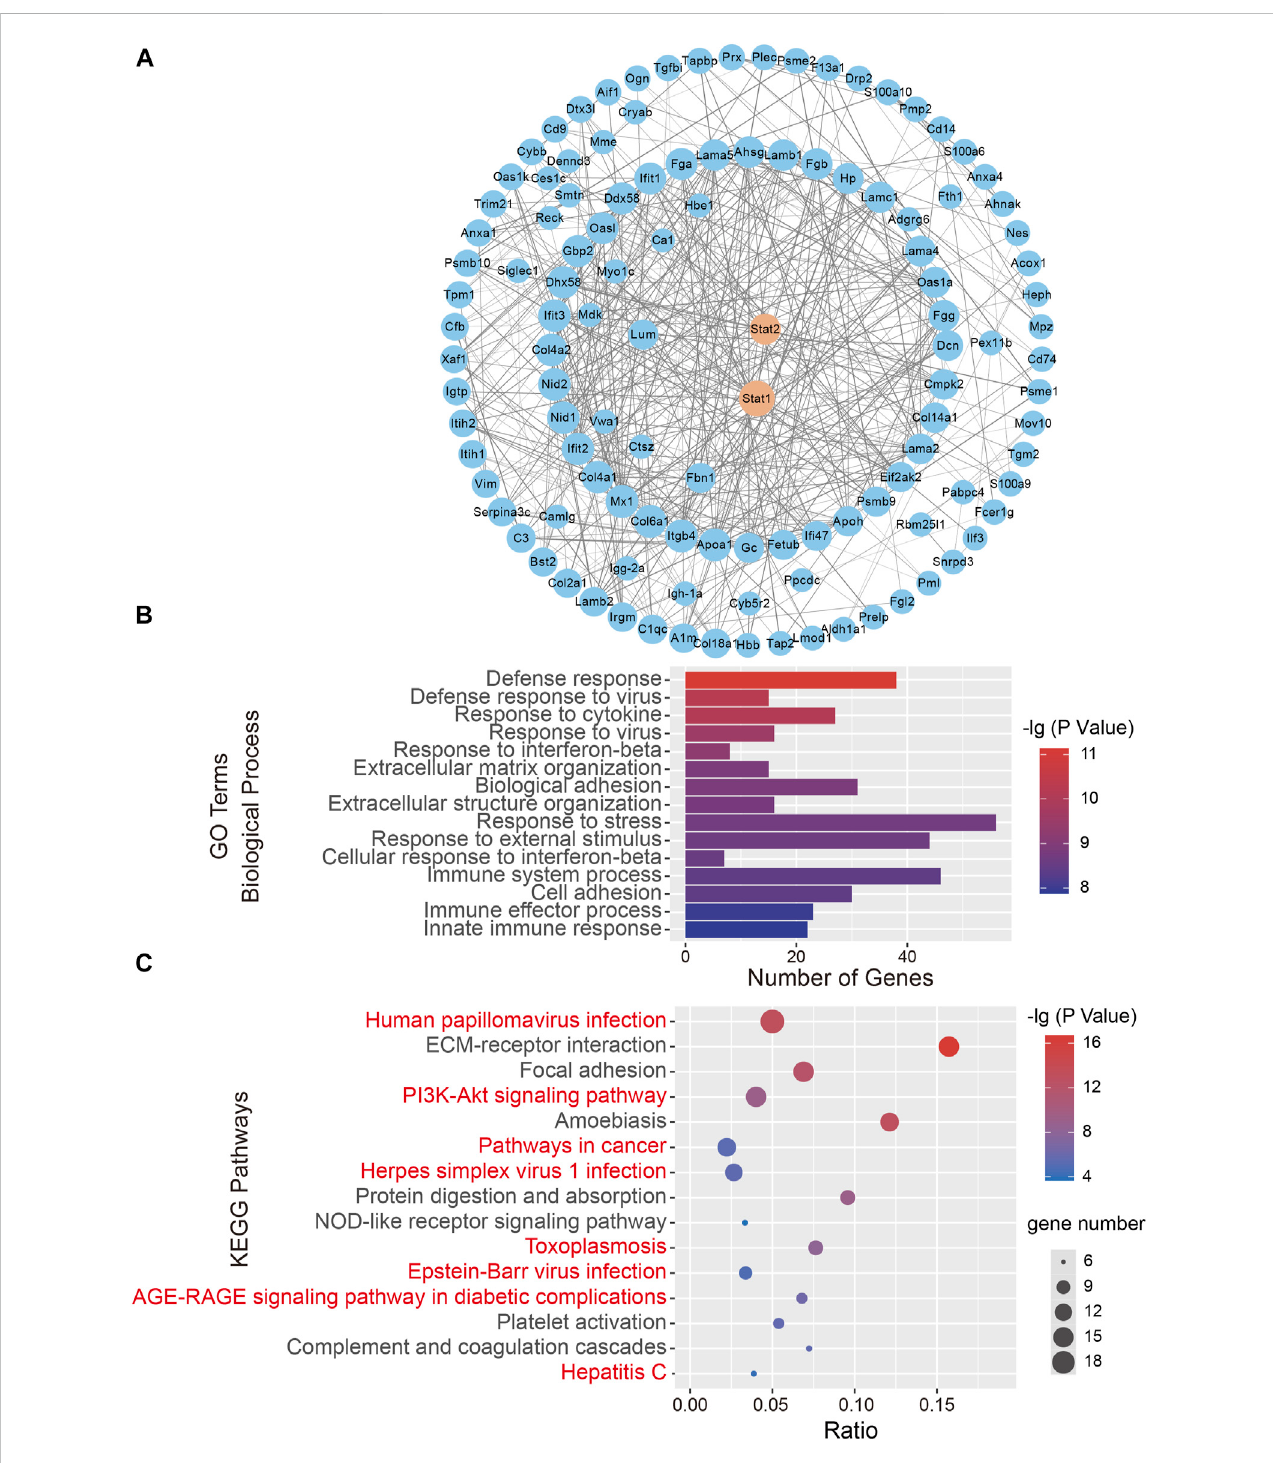
FIGURE 2 Bioinformatics analysis of 173 differentially expressed proteins (DEPs). (A) A protein-protein interaction (PPI) network analysis of DEPs. Network nodes representproteins.Edgesrepresentprotein-proteinassociations.PPIenrichment p < .001. (B) Thetop15biologicalprocessesinGeneOntology(GO)analysis. (C) The top 15 signi fi cantly enriched Kyoto Encyclopedia of Genes and Genomes (KEGG) pathways. The KEGG terms are plotted on the ordinate, and the enrichment factor is plotted on the abscissa. The size of the dots represents the gene number. The KEGG terms marked in red indicate eight signaling pathways directly related to STAT signaling